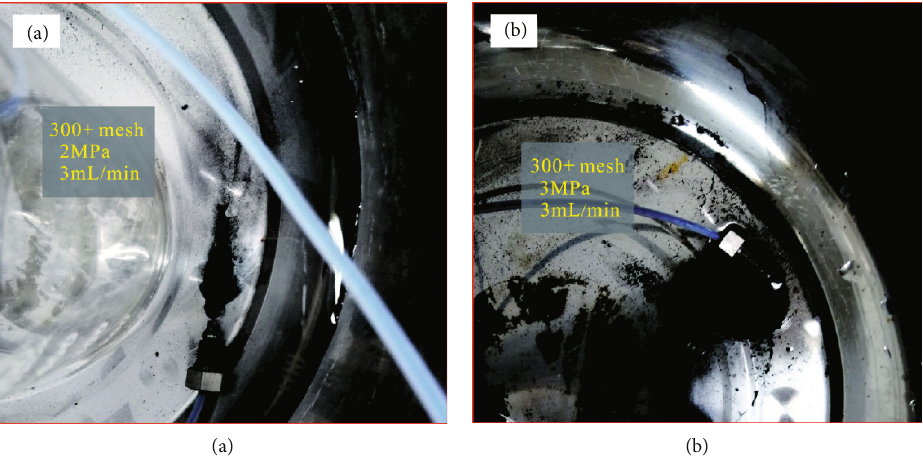
Figure 12: The phenomenon found coal fi nes output. (a) The condition: coal fi nes size of +300 mesh, fl ow velocity of 3 mL/min, and con fi ning pressure of 2 MPa. (b) The condition: coal fi nes size of +300 mesh, fl ow velocity of 3 mL/min, and con fi ning pressure of